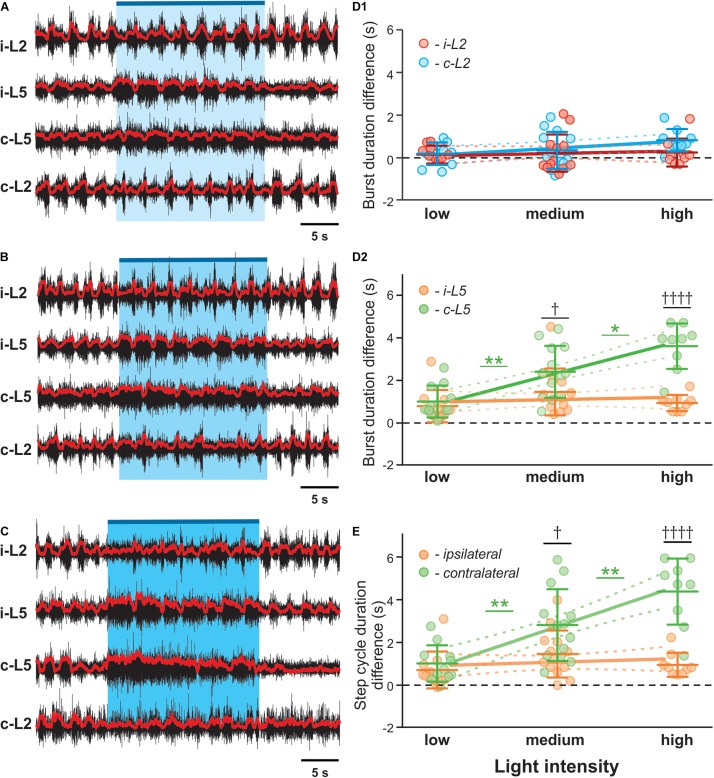
V3 activated contralateral extensor motor activity is correlated with optical stimulation intensity. Representative traces of locomotor activity induced by drug (5-HT 8 μM, NMDA 8 μM) in Sim1Cre/+; Ai32 cord at low (A), medium (B), and high (C) light intensity. Blue bar on the top of each trace and shaded blue area represent the optical stimulation period. The brightness of blue shaded area indicates light intensity. (D1,D2,E) Dependence of ENG characteristics on light intensity during biased optical stimulation. Average of burst duration difference of L2 (D1) and L5 (D2) between before and during optical stimulation under low, medium and high stimulation intensity during drug-induced locomotor-like activity (low n = 11, medium n = 13, high n = 9). ∗ Indicates 0.01 < P < 0.05, ∗∗ indicates 0.001 < P < 0.01. † indicates 0.01 < P < 0.05, †††† indicates P < 0.0001. Linear regression slope is orange for ipsilateral L5 and light green for contralateral L5 and red for ipsilateral L2 and blue for contralateral L2. (E) Step cycle period difference between ipsilateral and contralateral L5 under low, medium and high stimulation intensity during drug-induced locomotor-like activity (low n = 11, medium n = 13, high n = 9). †††† indicates P < 0.0001, ∗∗ indicates 0.001 < P < 0.01. Slope of contralateral L5 burst duration and step cycle difference are significantly non-zero.